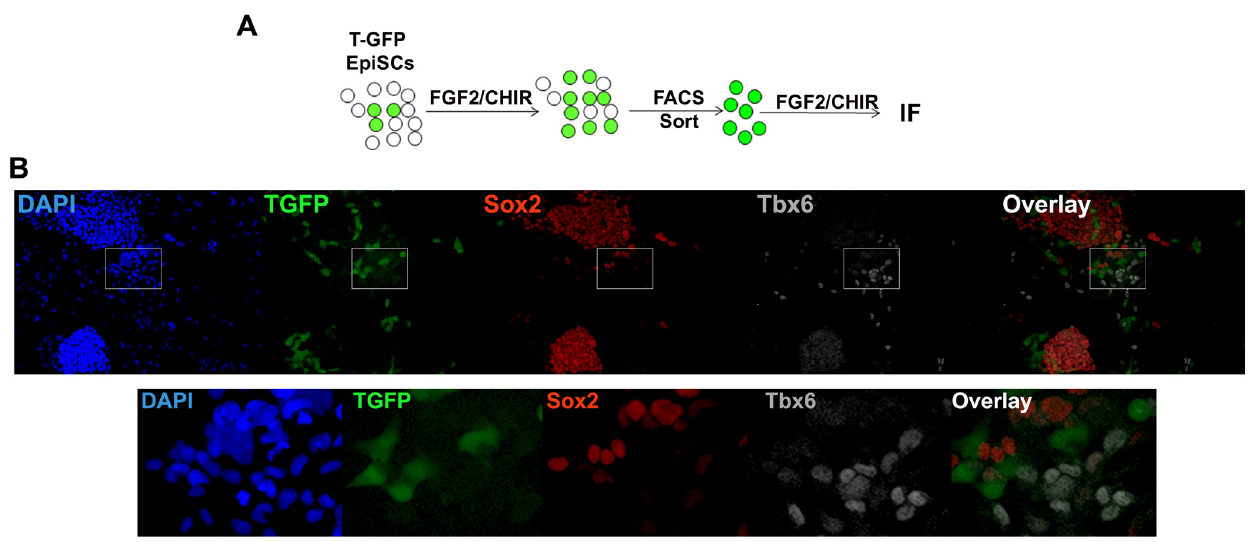
Figure 2. ( A ) Scheme depicting the differentiation and re-plating of in vitro induced NMPs at high density after flow sorting. ( B ) Fluorescence analysis and immunocytochemistry of TGFP, Sox2 and Tbx6 expression of in vitro -derived NMPs sorted at day 2 of differentiation and re-plated at high density in the presence of FGF2/CHIR for 2 days. In all cases cell nuclei were visualized using DAPI. IF: immunofluorescence. Magnified versions of the areas marked by a white box are shown in the bottom